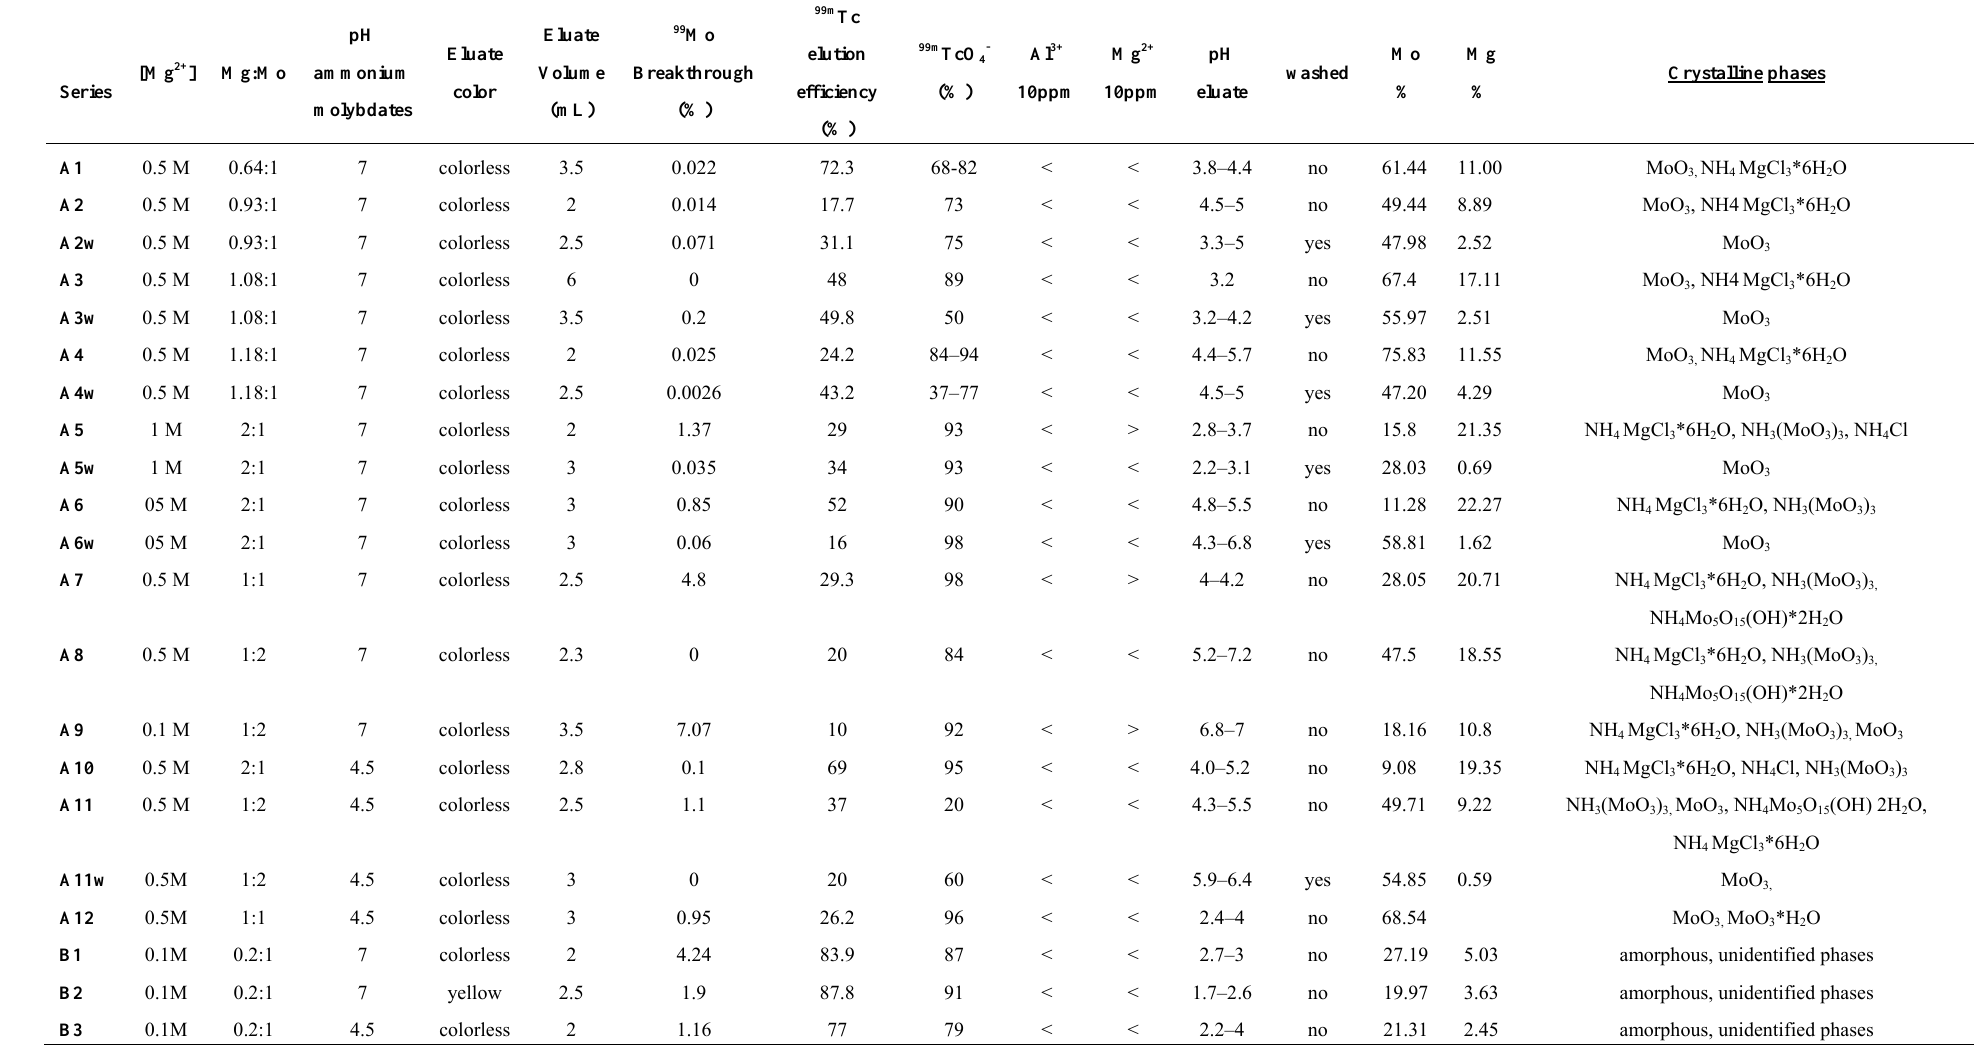
Table 1. Performances of 99 Mo/ 99m Tc generators based on magnesium 99 Mo-molybdate